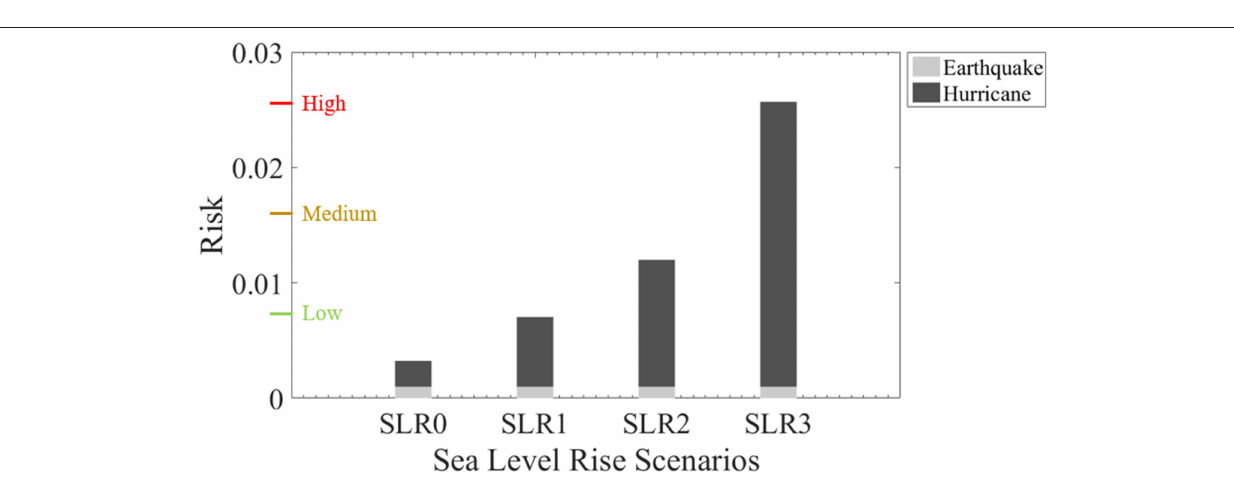
FIGURE 10 | Single and multi-hazard risk for the investigated sea-level rise